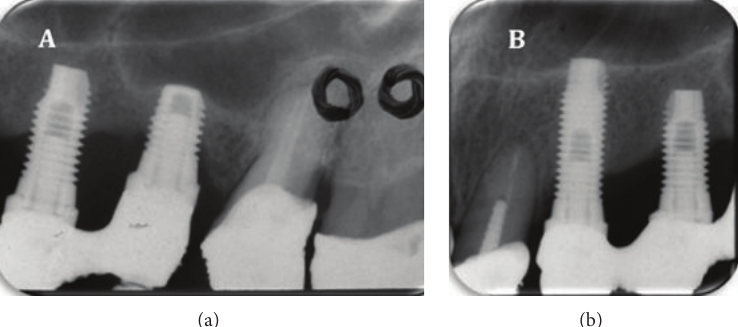
Figure 2: Radiographic initial appearance.